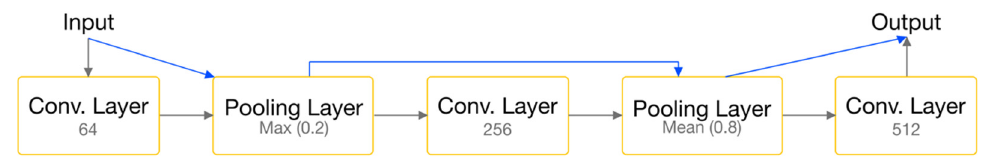
Figure 4. Conceptualised overview of one possible network architecture of the utilised GA’s build- ing blocks with skip-connections (blue) between layers (orange). The grey hyperparameters of each layer are variable; the CNN network architecture shown here would be represented by the genome as “64-0.2-256-0.8-512”.